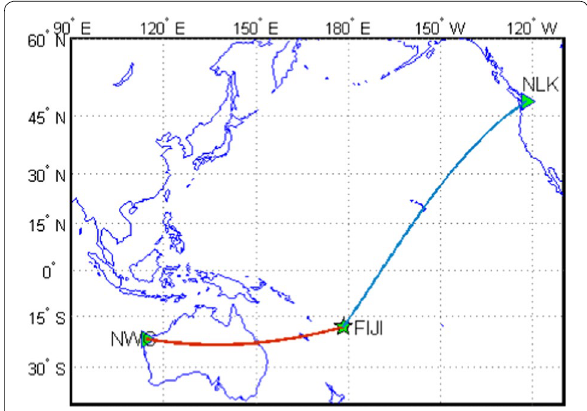
Fig. 1 Map showing the transmitters and receiver (Suva, Fiji) sites and their